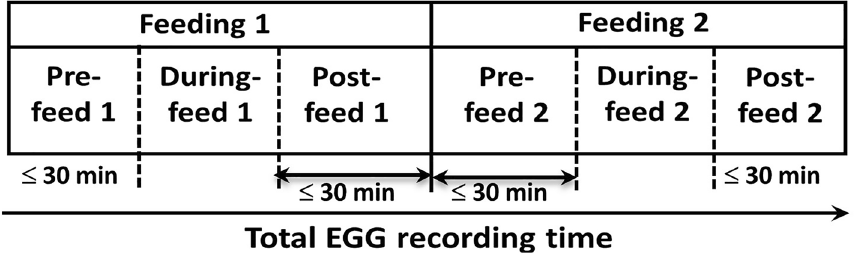
Figure 6. Feeding periods during EGG recording. EGG data were first sectioned into two feeding periods. Feeding 1 included Pre-feed 1, During-feed 1, and Post-feed 1. Feeding 2 included Pre-feed 2, During-feed 2, and Post-feed